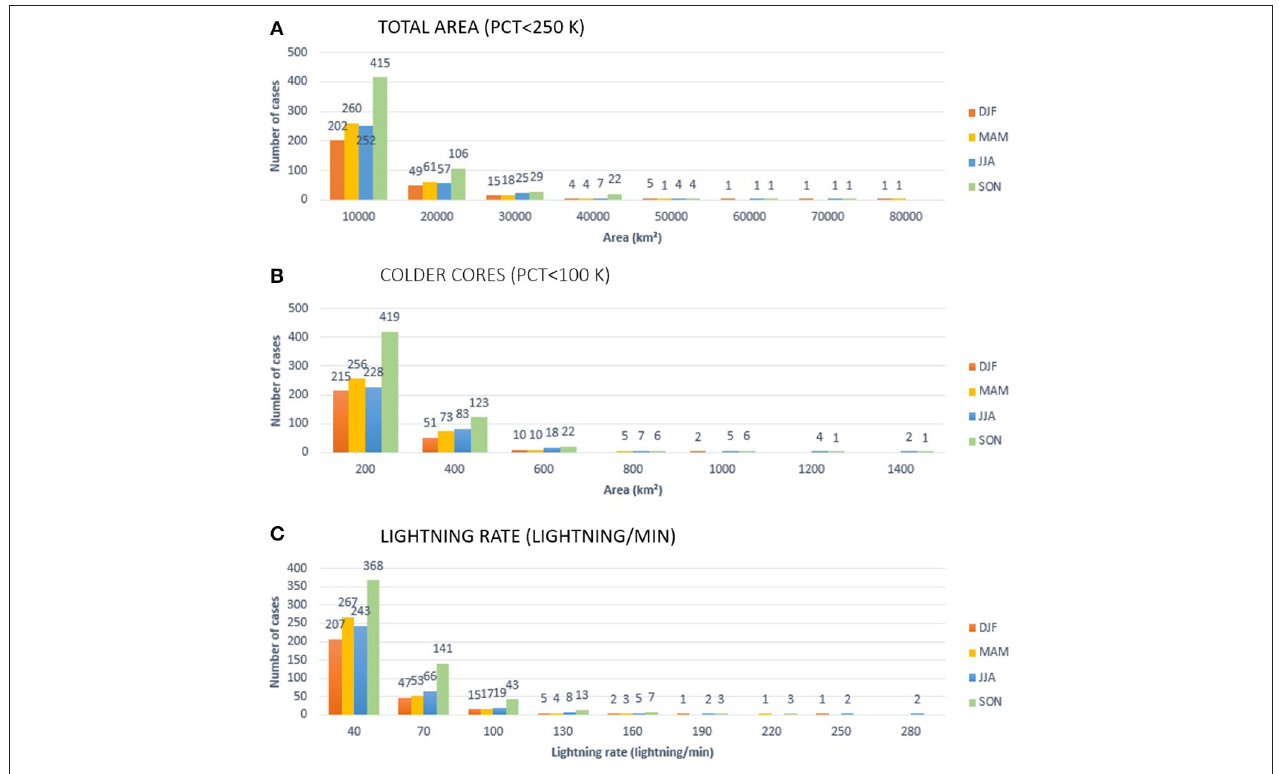
FIGURE 3 | Histogram of number of cases per season of potentially severe convection cases in subset 4, for 1998–2012, where: (A) total area of the system defined by PCT < 250K; (B) Area of the coldest region for PCT < 100 K; (C) Lightning rate.